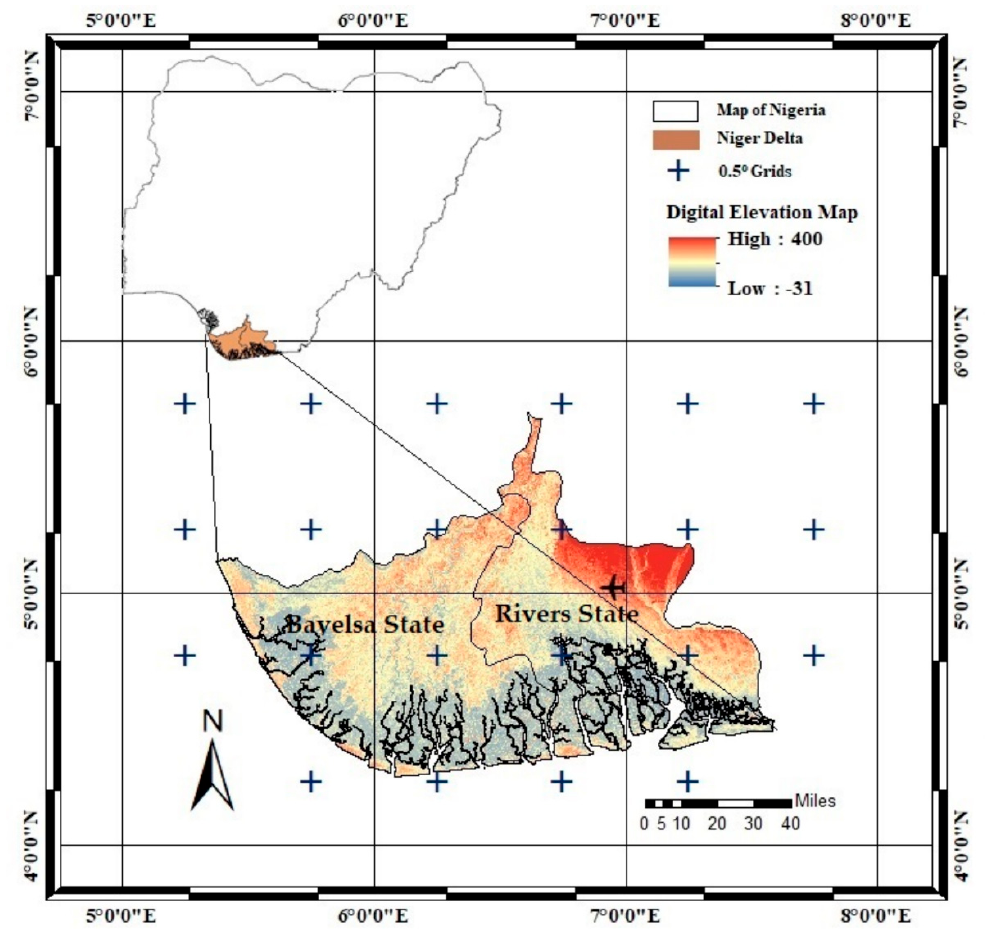
Figure 1. Map of the study area showing the spatial distribution of 0.5 ◦ × 0.5 ◦